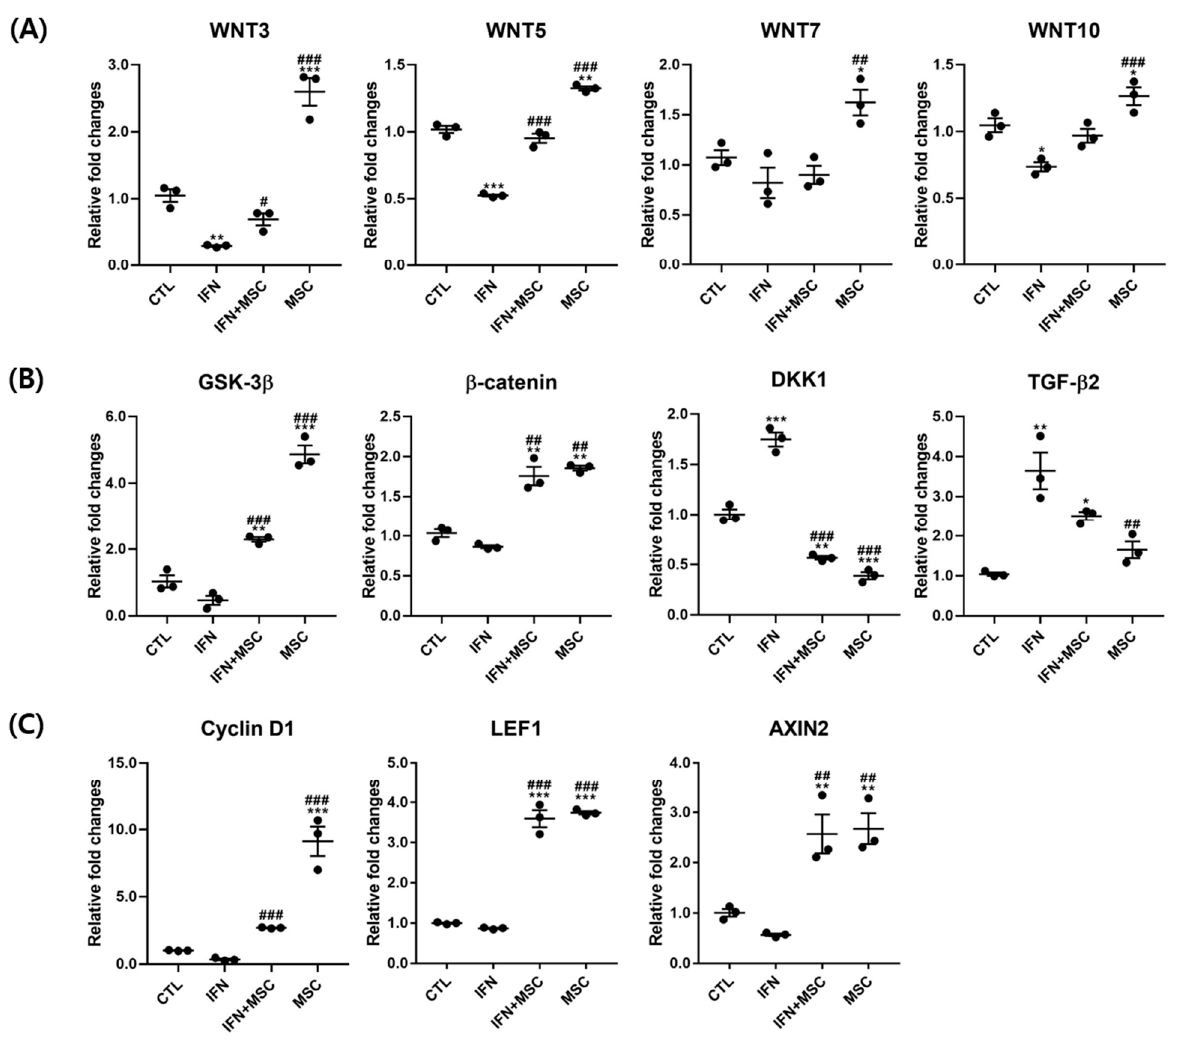
Figure 4. Analysis of gene expression by RT-PCR. The mRNA expression of ( A ) WNT3, WNT5, WNT7, WNT10, ( B ) GSK-3 β , β -catenin, DKK1, TGF- β 2 and ( C ) Cyclin D1, LEF1, AXIN2 in hORSCs. Wnt/ β -catenin-related genes were downregulated by IFN- γ and reverted by MSCT. DKK1, TGF- β 2 were inversely expressed. Error bars represent the mean ± SEM, n = 3. Statistically significant at * p < 0.05, ** p < 0.01, and *** p < 0.001 compared to the control and # p < 0.05, ## p < 0.01, and ### p < 0.001 compared to the IFN- γ -treated group.